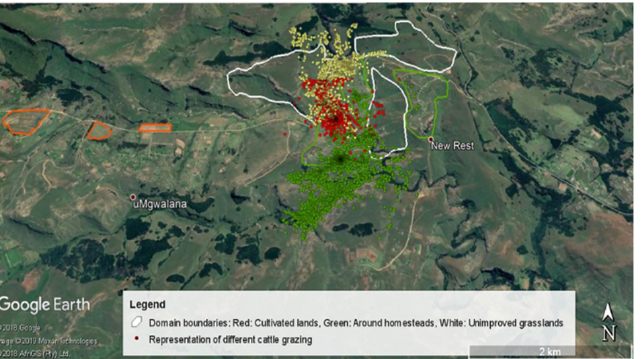
Figure 6. Google Earth plot showing the grazing distribution of three different cattle during the wet season.